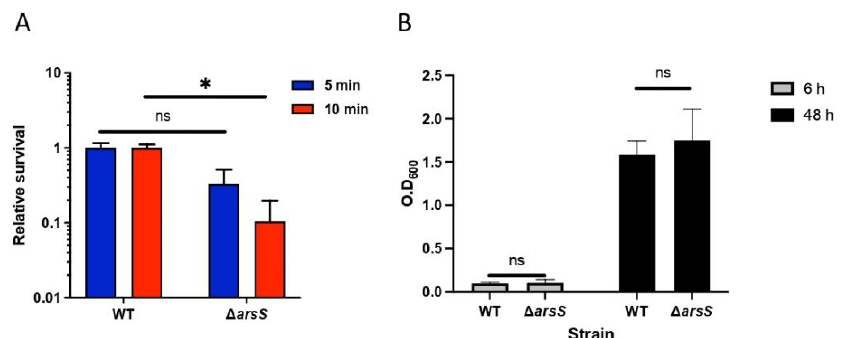
Figure 4. The effect of pH on the survival of H. pylori wild-type and ∆ arsS mutant. ( A ) Bacteria were incubated in pH 2.0 for 5 min or 10 min. Viable counts were determined by plating. Survival is expressed relative to the untreated control. Data are presented as the means and standard deviation of duplicate samples and are representative of three independent experiments. * p < 0.05, ns: non- significant. ( B ) Growth of H. pylori and the ∆arsS mutant in medium BB10 over time was measured by OD 600nm at 6 h and 48 h of incubation. Data are represented as the mean ± standard deviation from three independent experiments.